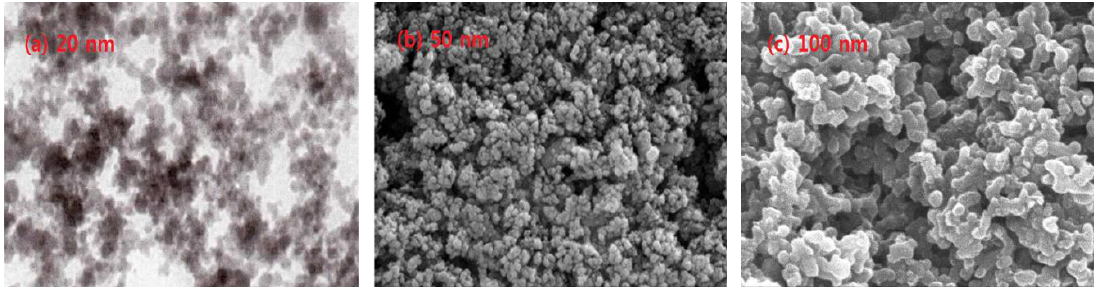
Figure 2. SEM micrograph of the Al 2 O 3 nanoparticles: ( a ) 20 nm; ( b ) 50 nm; ( c )100 nm.